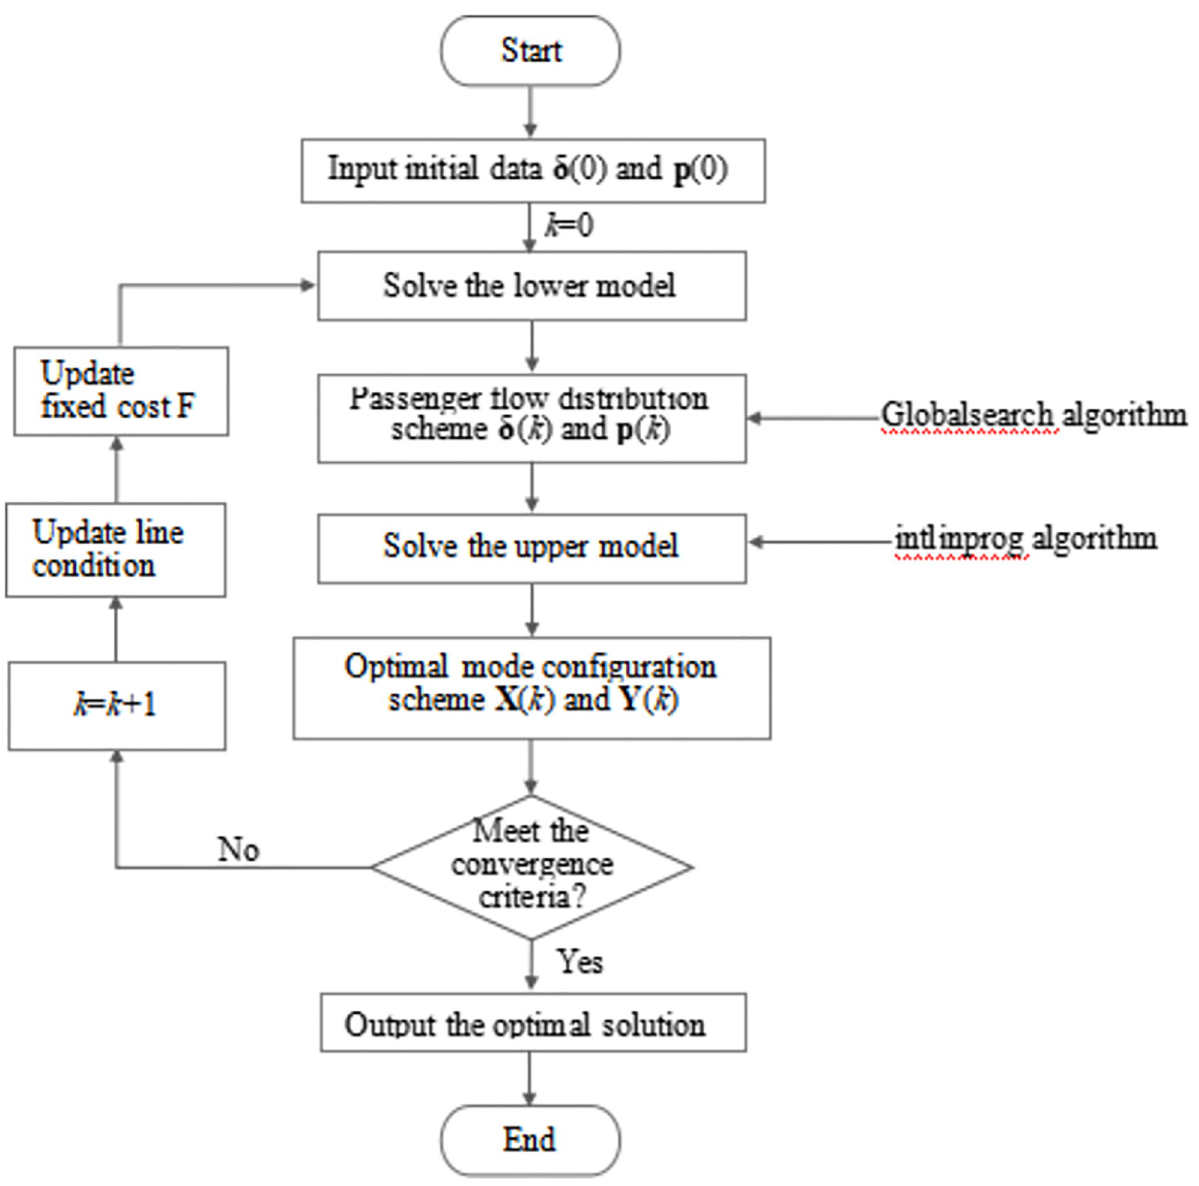
Fig 1. Flow chart of optimization